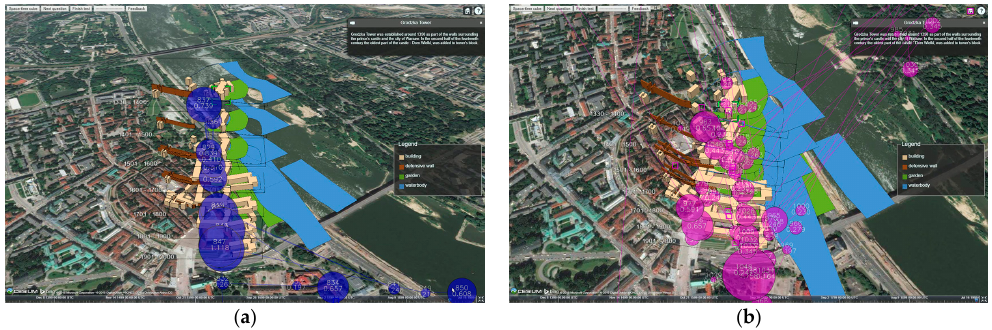
Figure 15. Searching strategies for Q3 in the space–time cube: ( a ) overview and relate; ( b ) overview, relate, and details-on-demand.